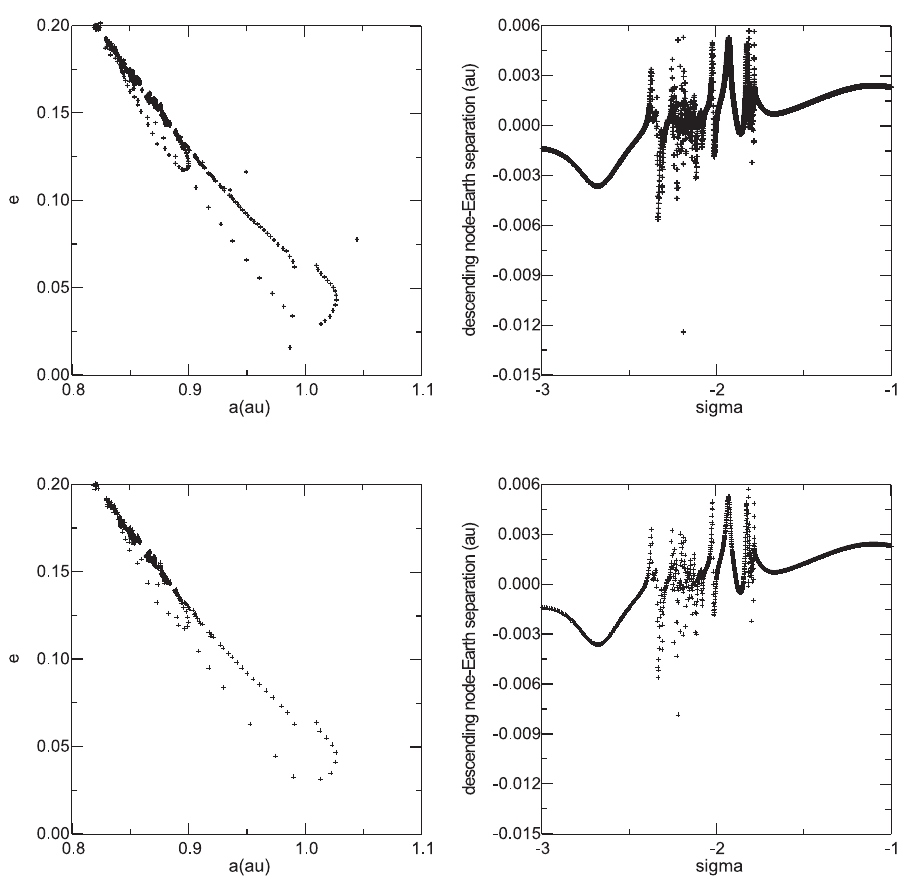
∆ Figure 7. The same as in Figure 5 but for σ max =5 and ∆σ max =0.01. Additionally, IP = 1· 10 −8 which gives 42902 multiple solutions for top panels and IP = 2· 10 −8 with 21625 multiple solutions for bottom panels. For better visibility, the sigma-axis is limited to the range (−3,